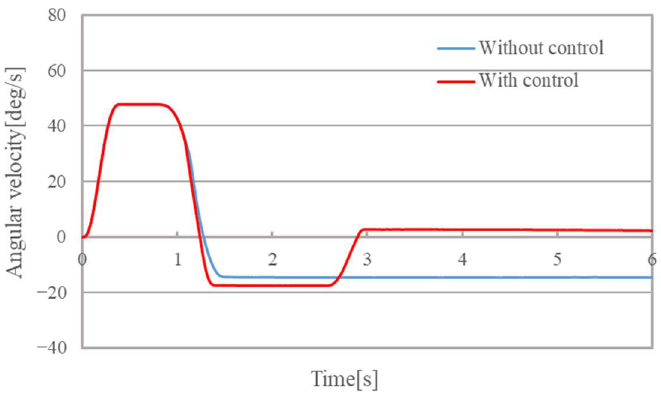
Figure 12. Time history of angular velocity (numerical results).